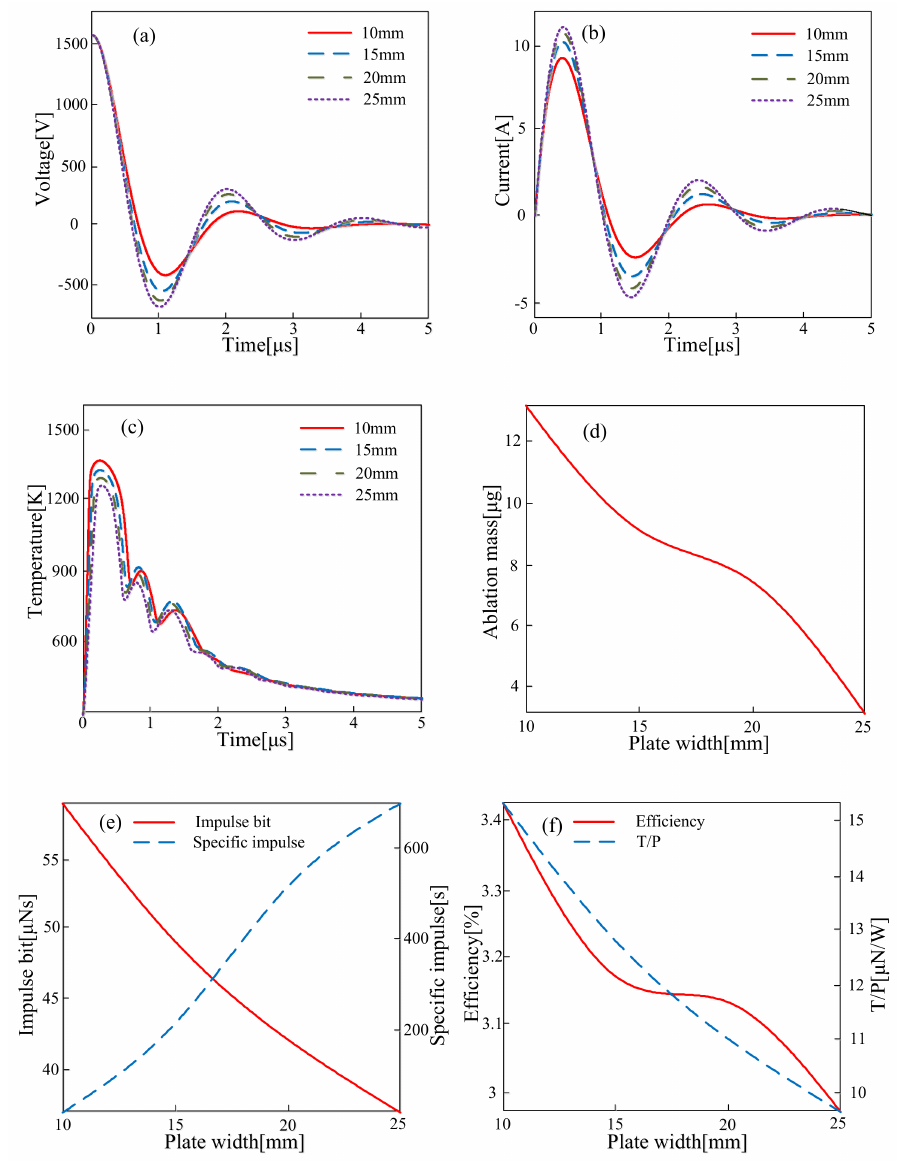
Figure 12. Simulation results at different plate widths: ( a ) Discharge voltage waveform; ( b ) discharge current waveform; ( c ) variation of ablation surface temperature with time; ( d ) variation of ablation mass with plate width; ( e ) variation of impulse bit and specific impulse with plate width; ( f ) variation of efficiency and ratio of thrust to power with plate